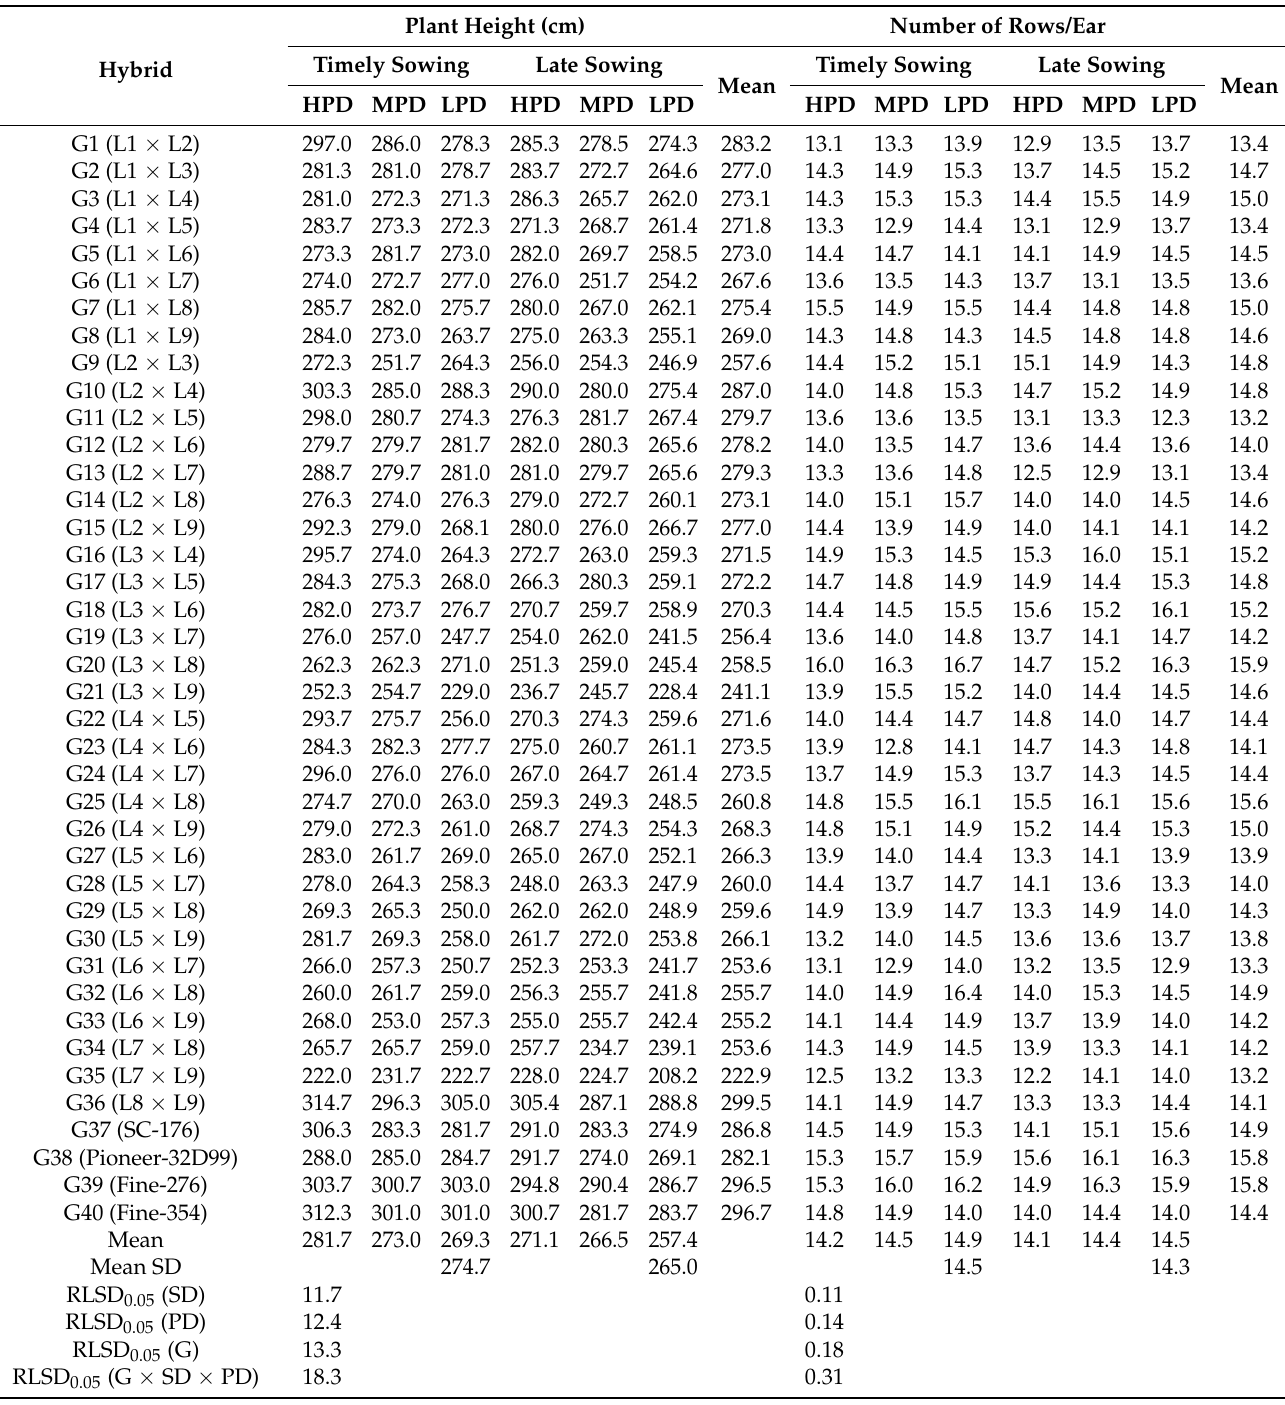
Table 2. Impact of sowing date and planting density on plant height and the number of rows/ear of the evaluated 40 maize